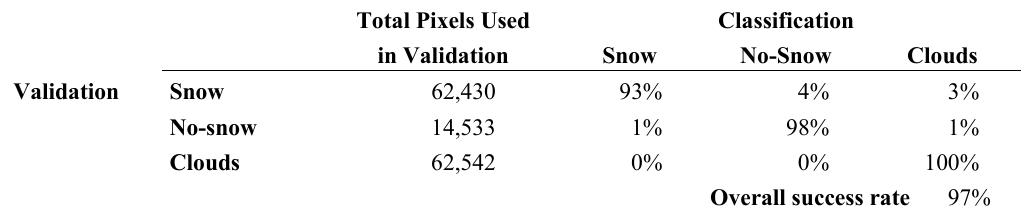
Table 2. Pixel-based validation of the new AVHRR algorithm using the independent validation